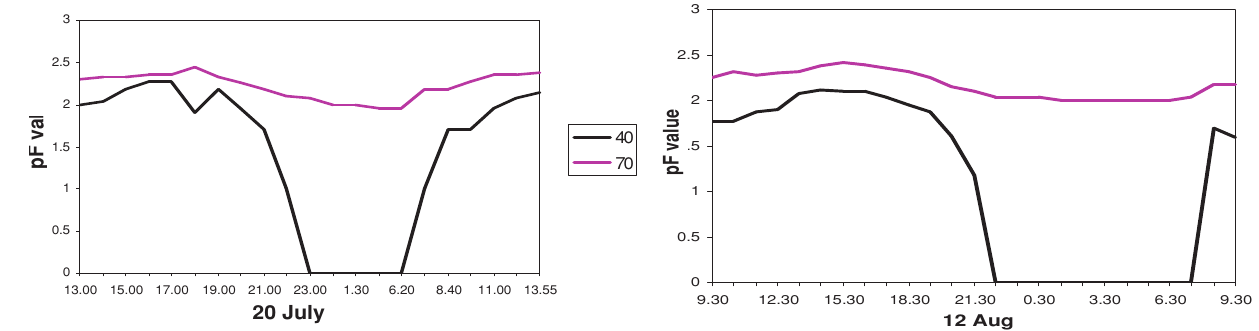
Figure 6: Daily fluctuation of pF